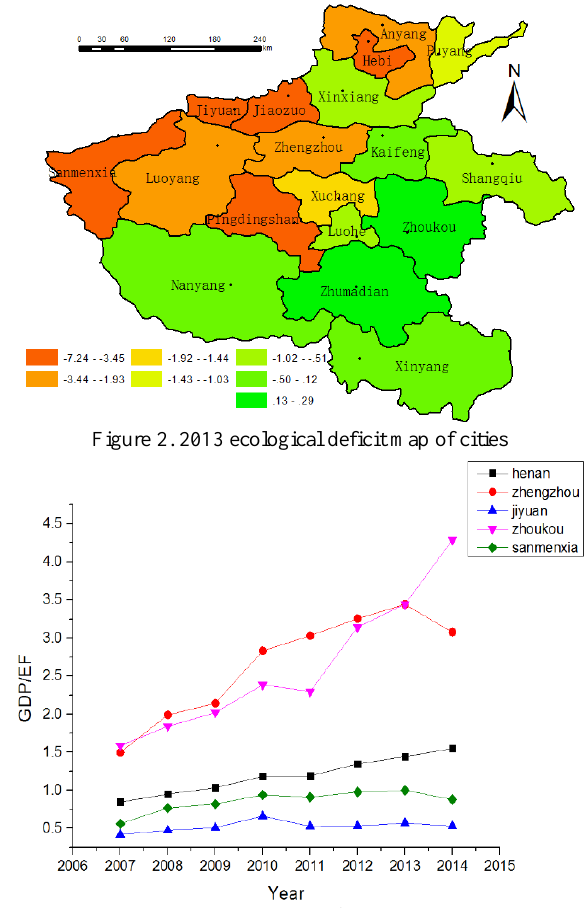
Figure 3. 2007-2013 GDP/EF of Henan and some cities